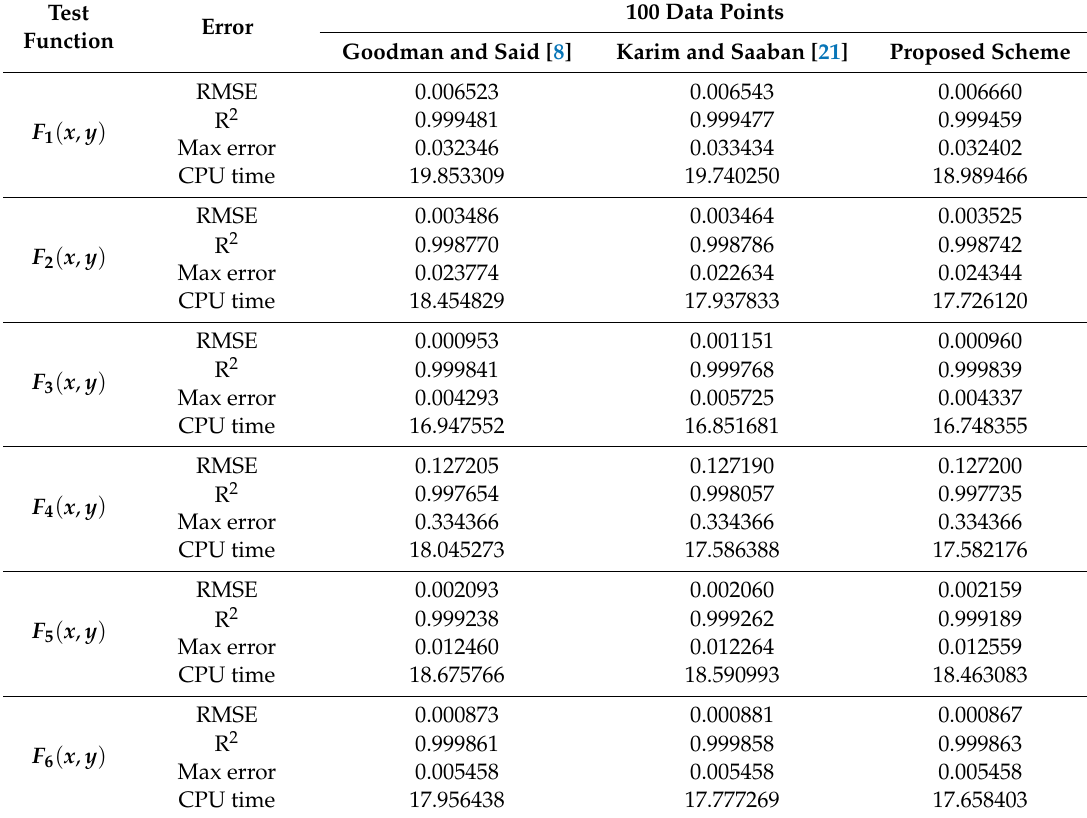
Table 8. Comparison with established